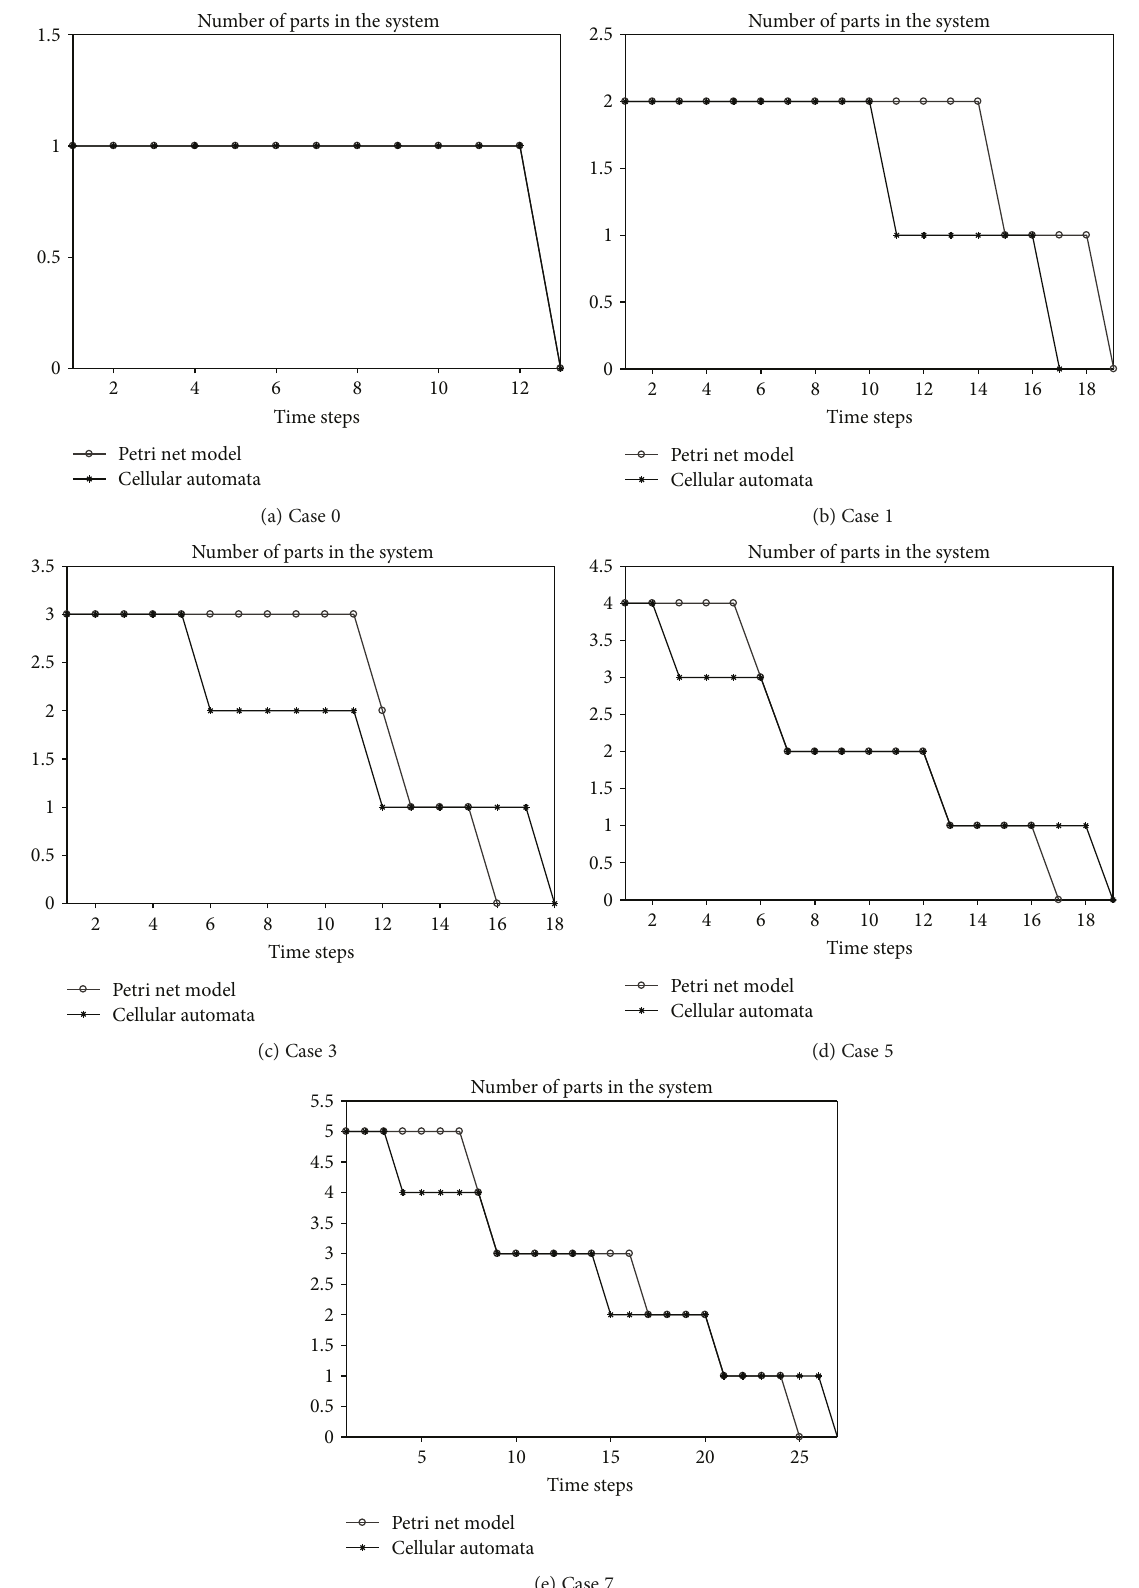
Figure 14: Plots showing the reduction of parts as they depart from the